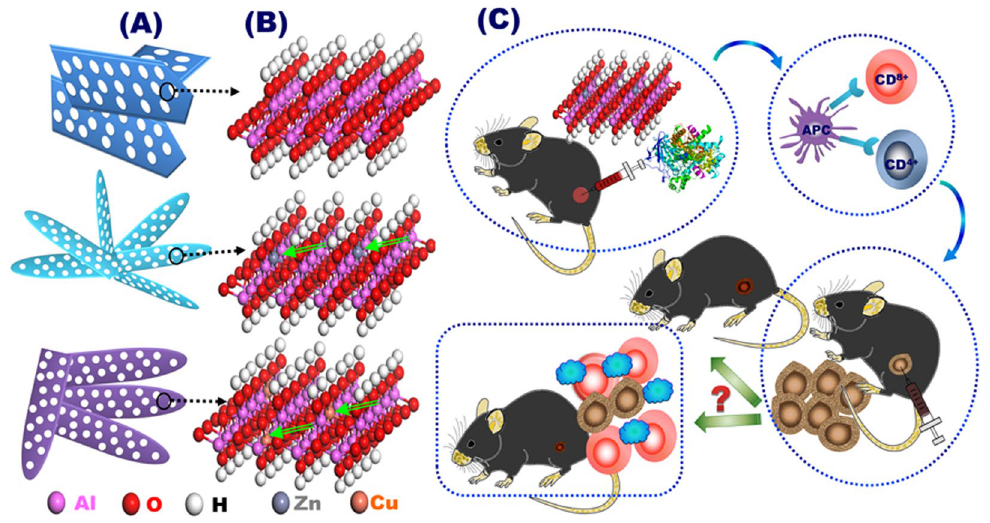
Figure 1. Hierarchical Cu- and Zn-buds dressing γ -AlOOH mesostrands that act as immunoadjuvants for stimulating anti-tumor immune response. ( A , B ) mesoscale atomic arrangements of hierarchical Cu- and Zn-buds dressing γ -AlOOH mesostrands morphology ( A ) and crystal structures ( B ). ( C ) The method for activation of anti-tumor immune response as follows: (i) immunization of mouse with the Cu-, and Zn-AMSs- OVA complex; (ii) antigen-presenting cells accumulation and antigen presentation to T cells; (iii) subsequent injection of EG7-OVA cancer cells; and iv) checking test of whether the tumor growth was